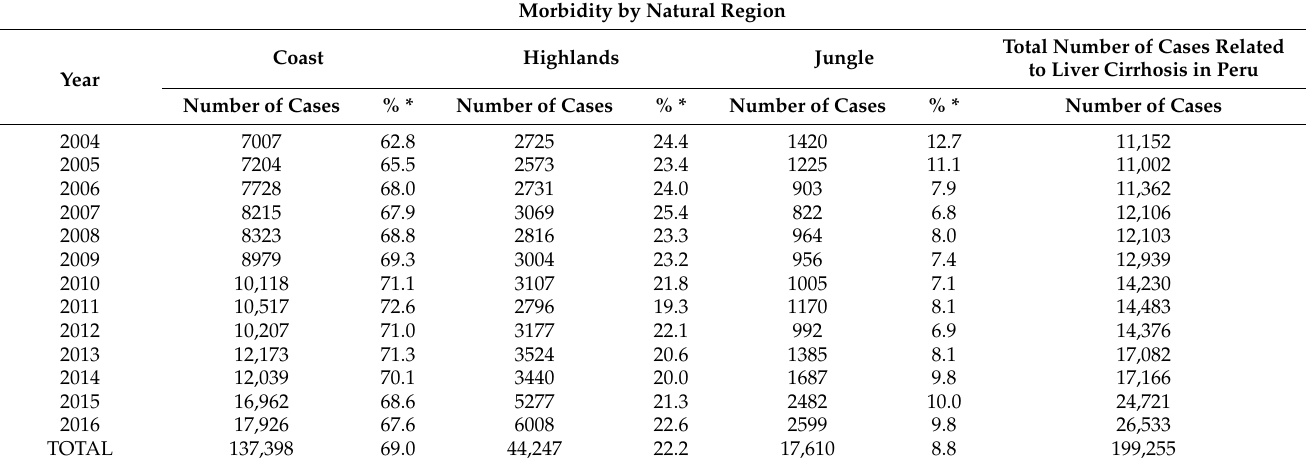
Table 1. Morbidity and complications related to liver cirrhosis according to region and year of death for the period 2004-2016.